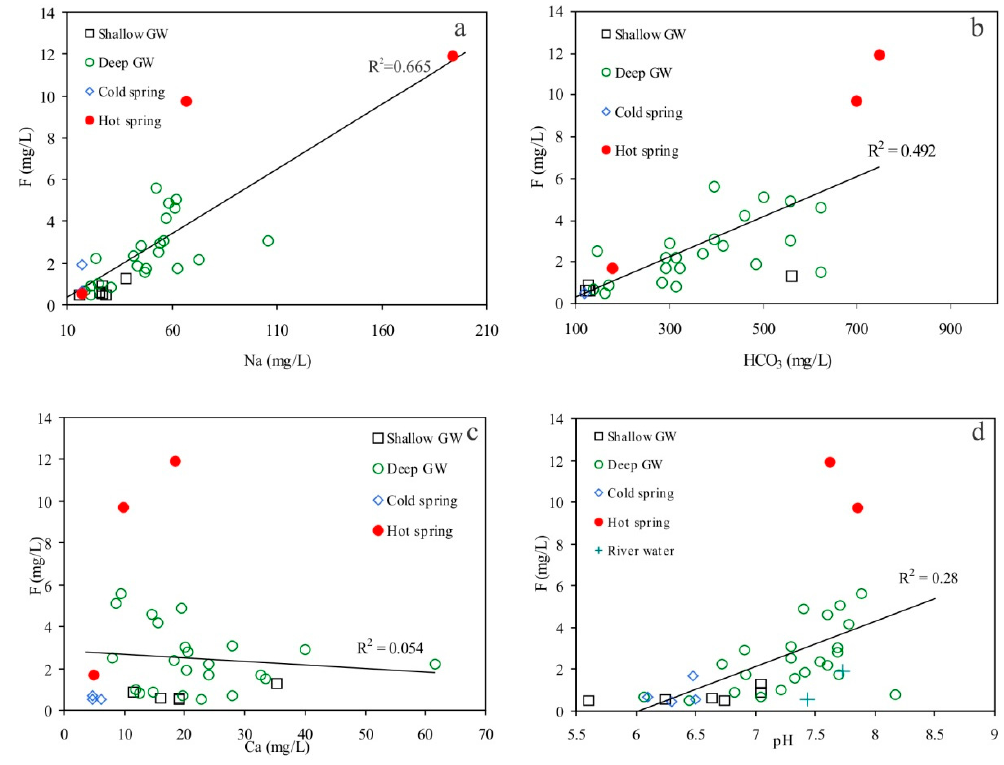
Figure 8. ( a ) Plot of Na + vs. F − , ( b ) HCO3 − vs. F − , ( c ) Ca 2+ vs. F − and ( d ) F − vs. pH.